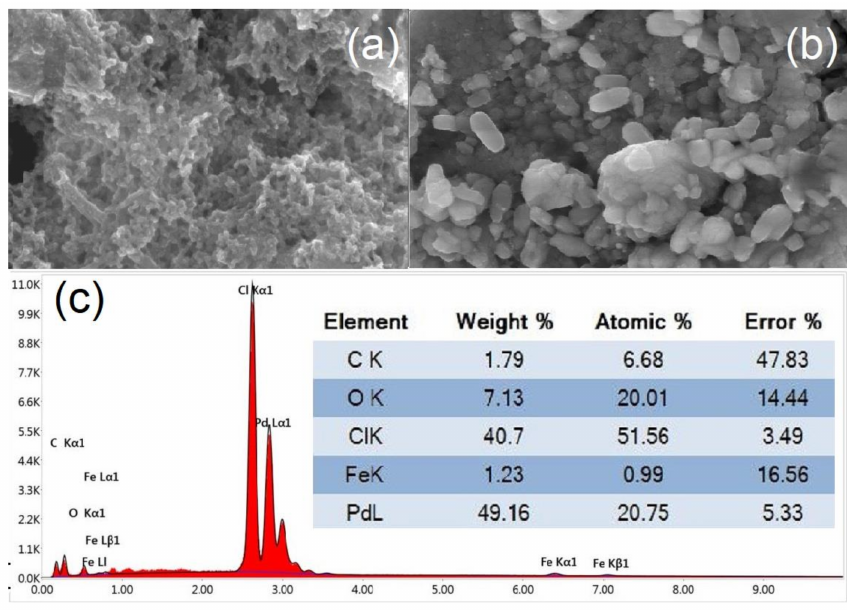
Figure 11. The images of SEM of Pd-NPs are shown in ( a , b ). ( c ) EDX data of biosynthesized palladium nanoparticles.